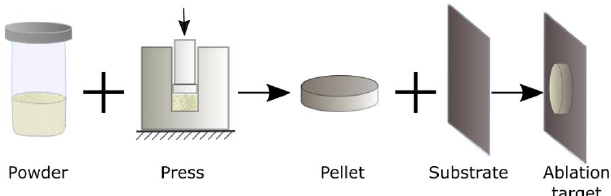
Figure 1. Schematic representation of ablation target preparation. The initial Sm oxide micro powder was pressed into a cylindrical pellet, which was then glued to a silicon wafer to form the ablation target.